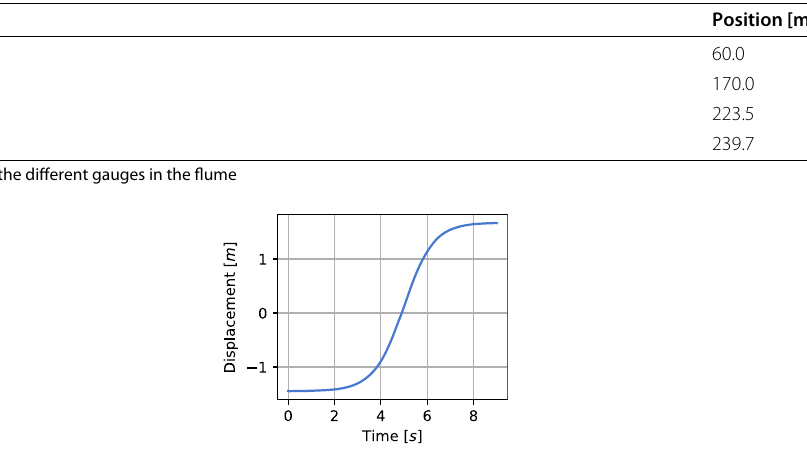
Fig. 4 Solitary wave example. Paddle position according to time. Data provided in Krautwald et al. [63–65] at key positions of the channel and allow us to monitor wave generation (G1), propagation (G2), shoaling (G3) and flooding